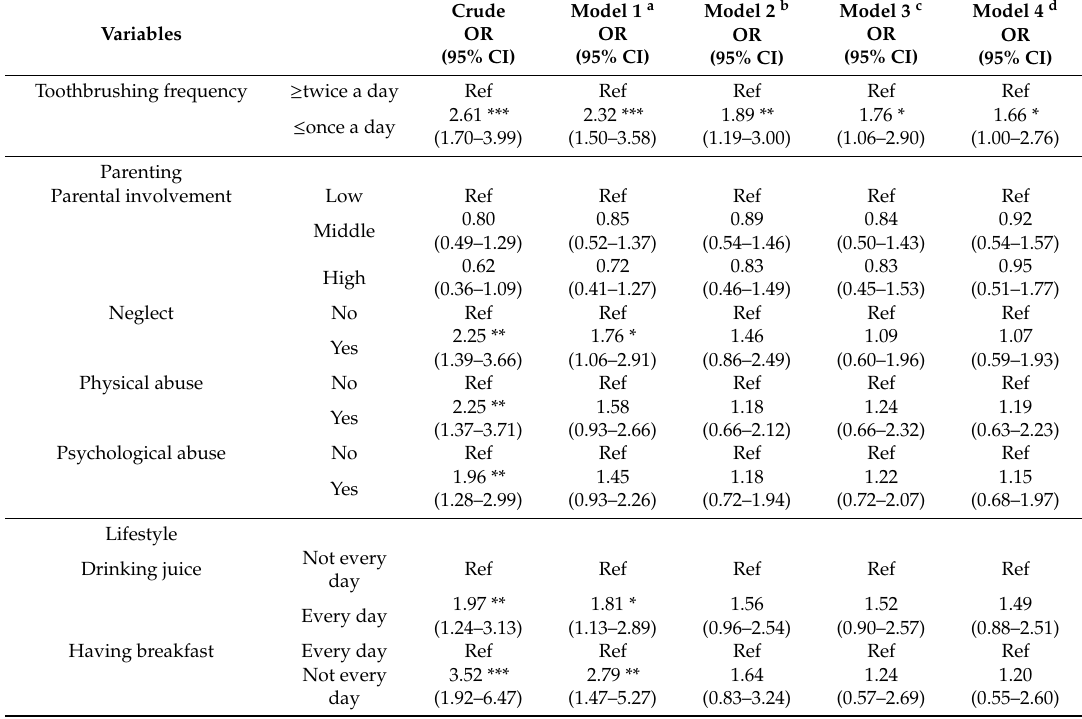
Table 2. Association of toothbrushing frequency with school refusal in logistic regression analysis.